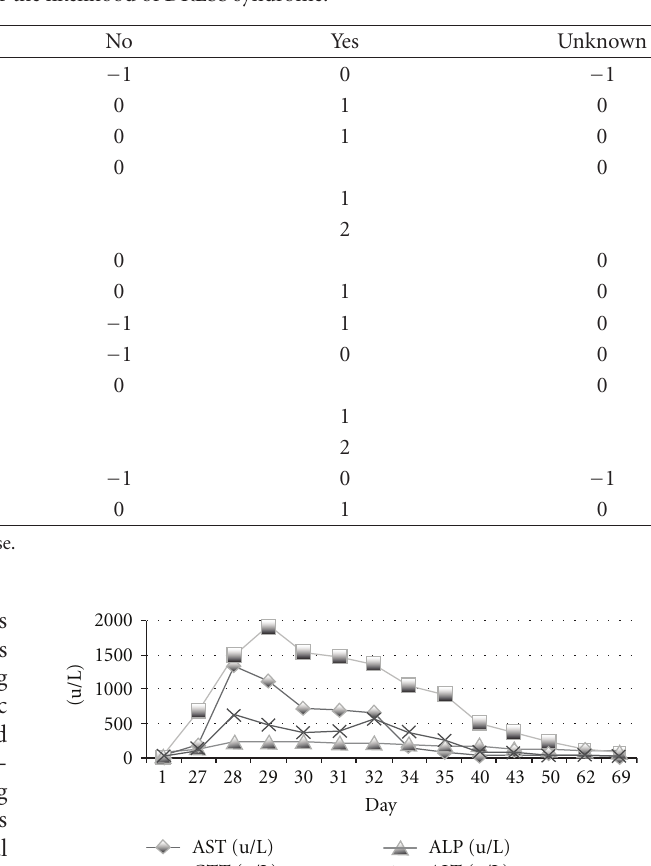
Table 1: RegiSCAR criteria for the likelihood of DRESS syndrome.